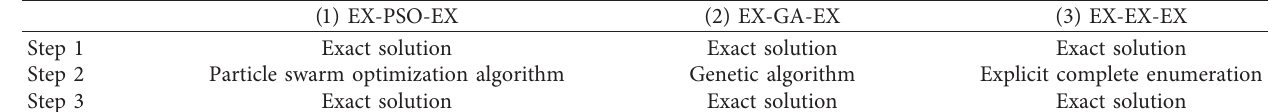
Table 2: Proposed approaches for solving the BHLRP based on a three-stage strategy.